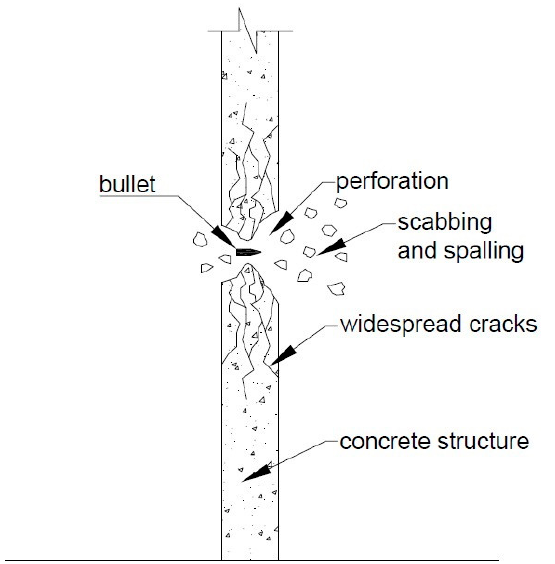
Figure 1. Normal concrete wall under projectile impact.